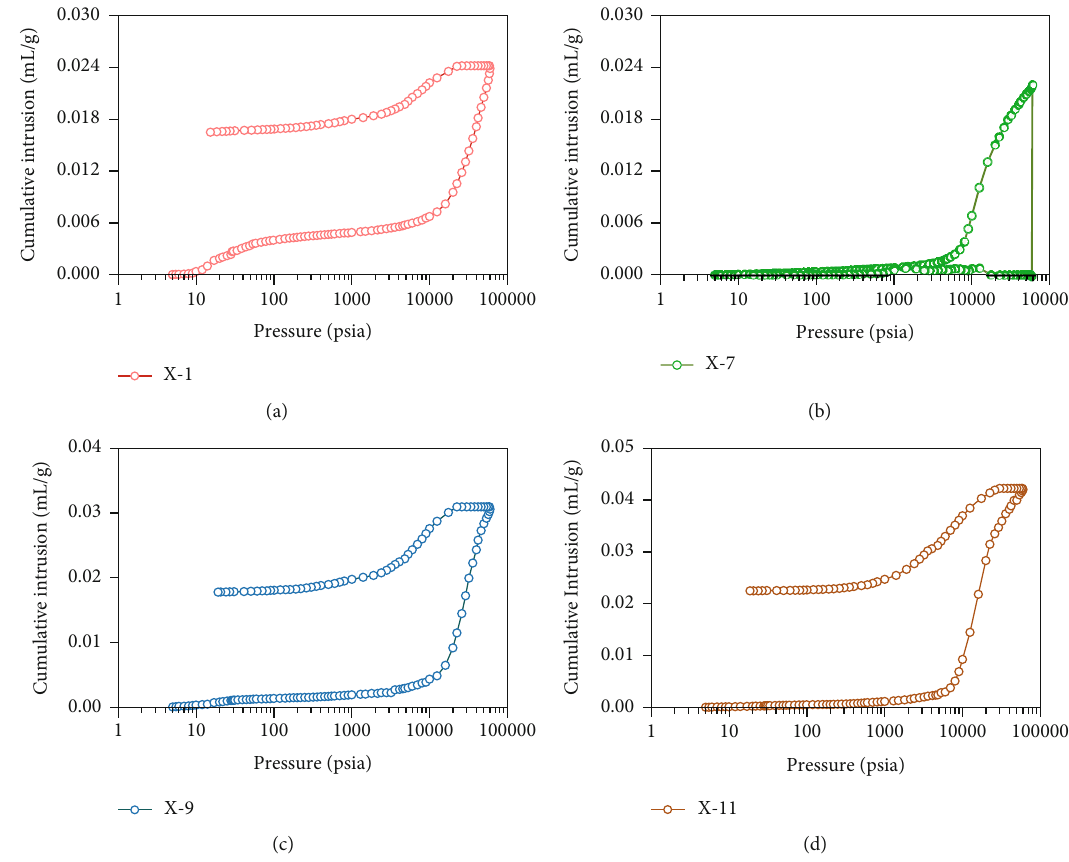
Figure 9: Hysteresis curves of drainage (mercury intrusion) and imbibition (mercury extrusion) from MIP tests.